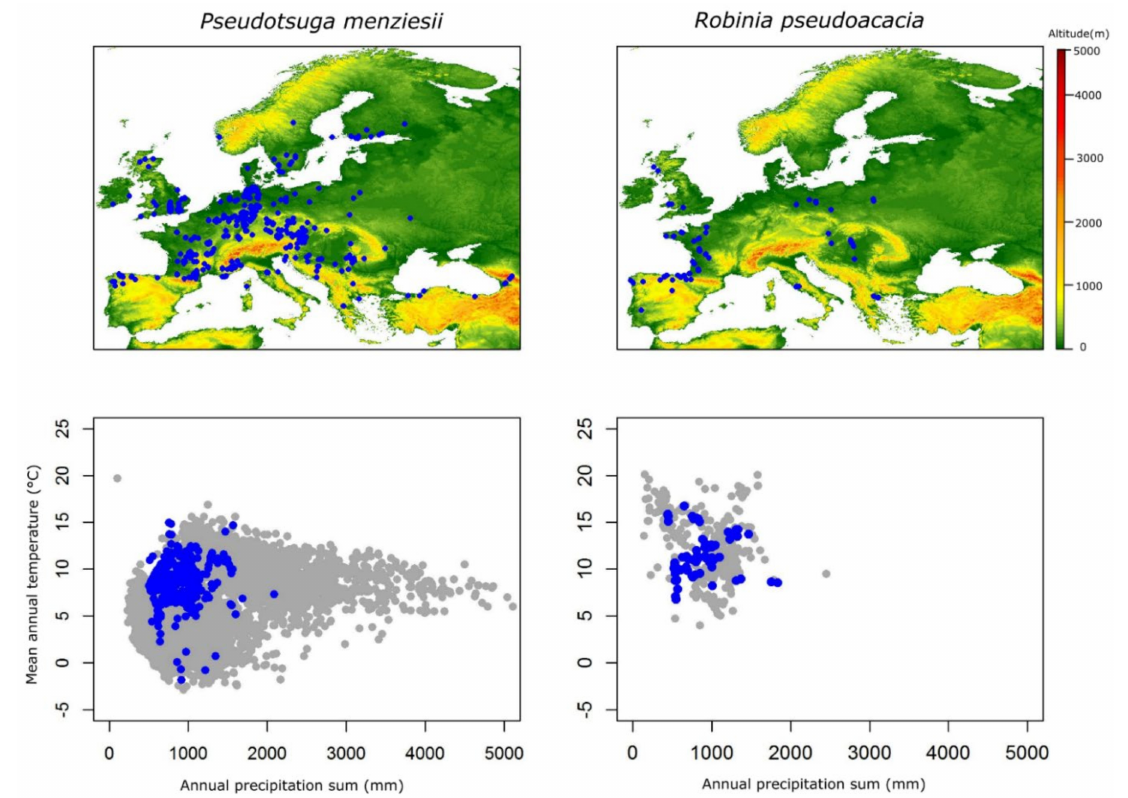
Figure 1. Geographic location of established genetic trials in Europe for the five non-native tree species of interest is indicated (map), together with their display within the bioclimatic parameter space represented by mean annual temperature and mean annual precipitation of the regions where each non-native tree species grows naturally (blue dots: bioclimatic plot of the establishment sites of genetic trials in Europe, grey dots: bioclimatic space of each species in its natural